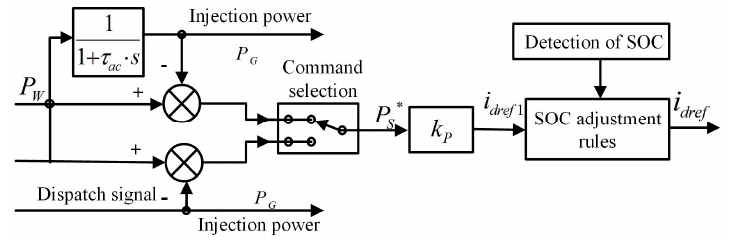
Figure 11. Generation of reference active current.